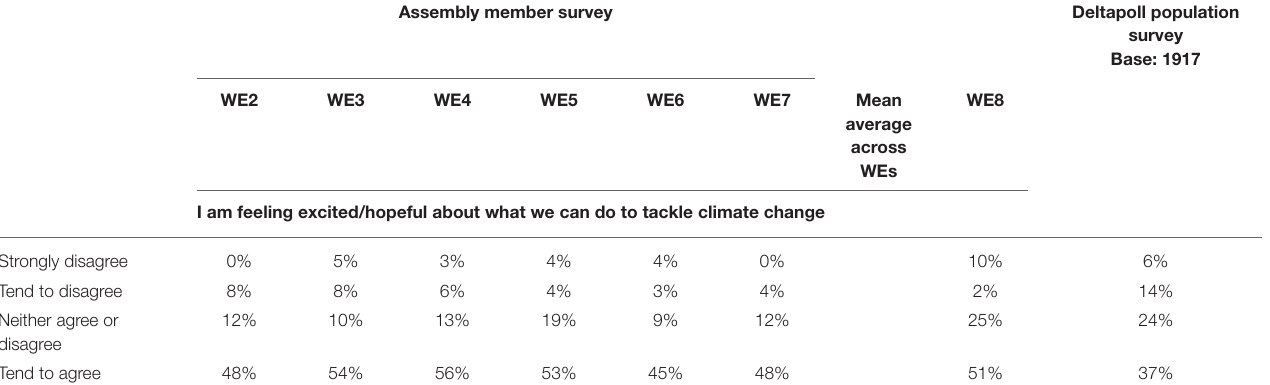
TABLE 3 | Member survey and population survey